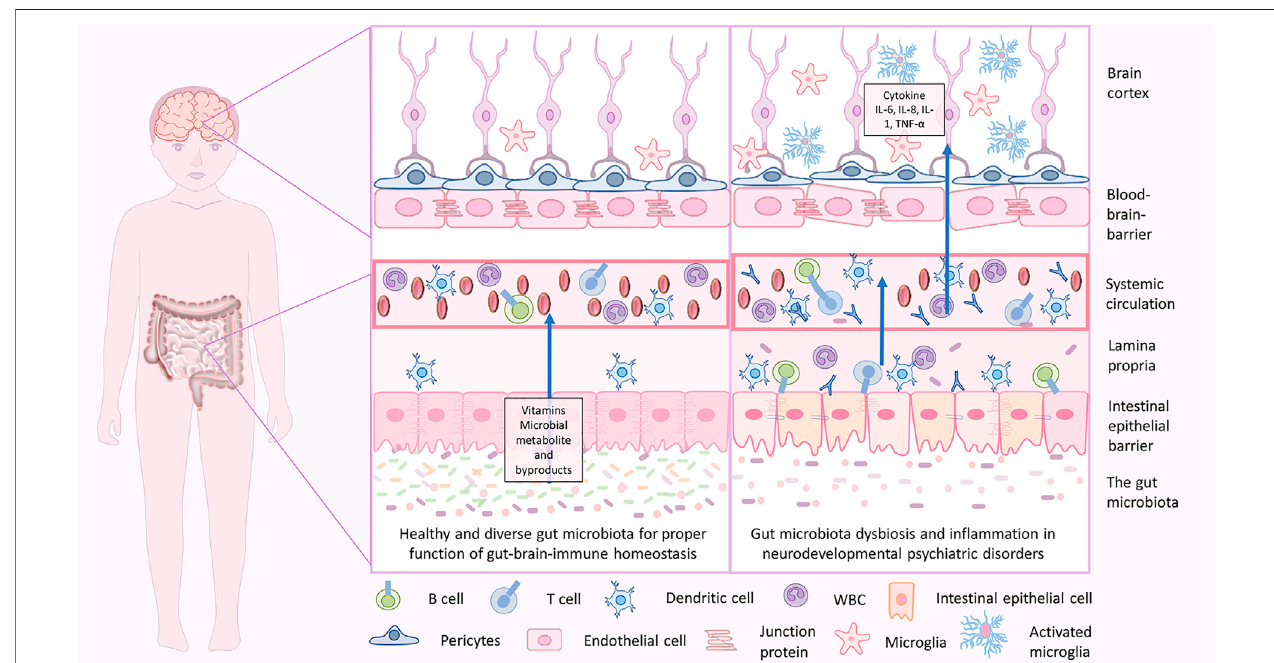
FIGURE3| Gut-brainhomeostasisandin fl ammatorymechanismsinneurodevelopmentalpsychiatricdisordersduetogutbraindysbiosis.Ininfancy,thedysbiotic gutischaracterizedbylessdiversemicrobiotawithanabundanceofpathogenicmicrobes, lessbene fi cialmicrobes, anddisruptedgutepithelialbarrierwithconsequent GI tract-related disorders. When severe, the pathogenic microbes may cross through and enter the blood, which holds a massive immune response and releases in fl ammatory cytokines that lead to in fl ammation. Cytokine imbalance can induce microglial activation in the brain, which again causes neuroin fl ammation. This is associated with a disruption in brain development, and delay in neurodevelopmental subsequently may lead to NDD and NPDs.